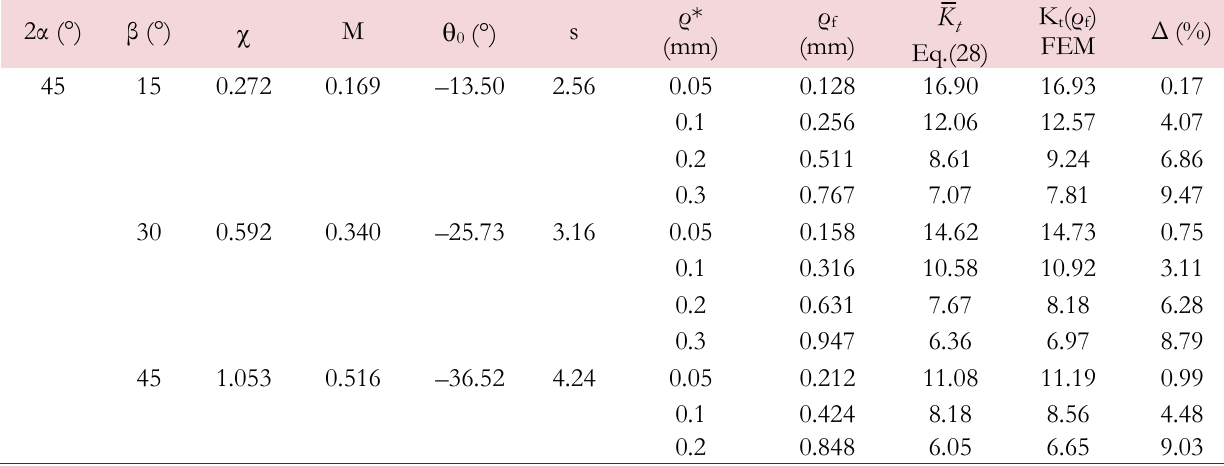
Table 2: FNR results for mixed mode loading conditions; normal stress failure criterion combined with the MTS criterion for  0 ; different values of the microstructural support length  * and the mode ratio